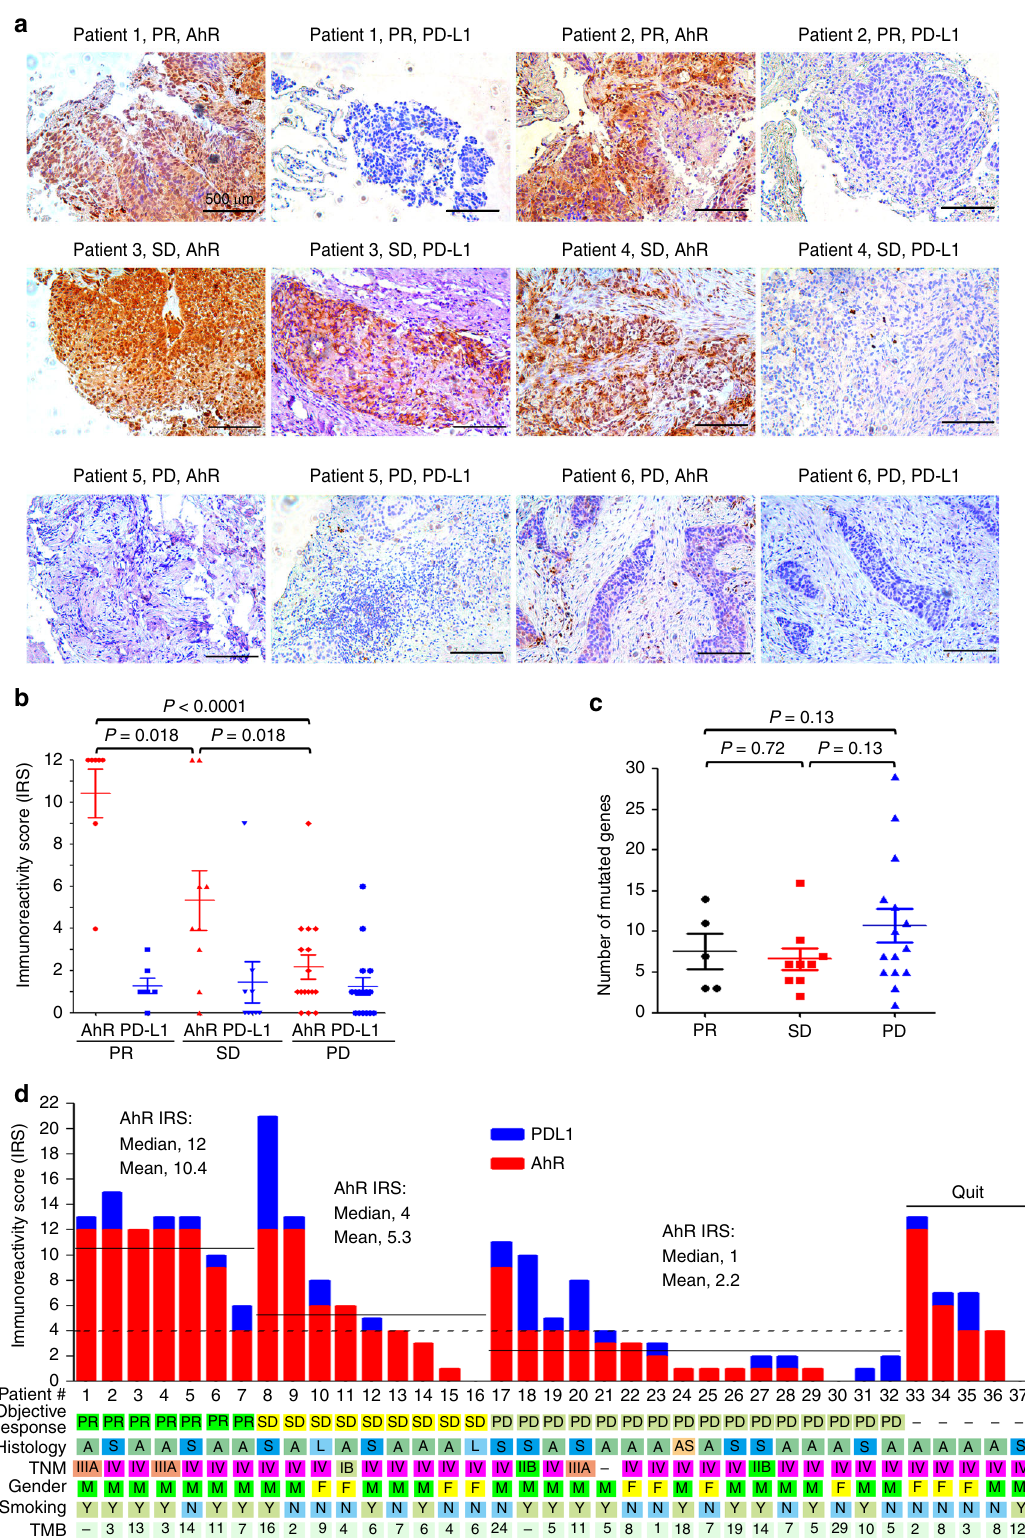
Fig. 5 AhR expression is associated with clinical bene fi ts of PD-1 blockade. a The expression of AhR and PD-L1 (detected by IHC) and response of the patients to pembrolizumab. b IRS of AhR and PD-L1 in patients achieved PR, SD, or PD. c A total of 422 genes (supplementary Table 1) were sequenced in 35 out of the 37 patients, and the number of mutated genes per sample are shown. Error bars, sd. P values in b, c, Student ’ s t test. d Clinical characteristics, AhR/PD-L1 IRS, TMB, and response of the patients to pembrolizumab. Objective response: PR partial response, SD stable disease, PD progression of disease. Histology: A adenocarcinoma, AS adenosquamous carcinoma, L lymphoepithelioma-like carcinoma of the lung, S squamous cell carcinoma. Gender: F female, M male. Smoking: Y yes, N no